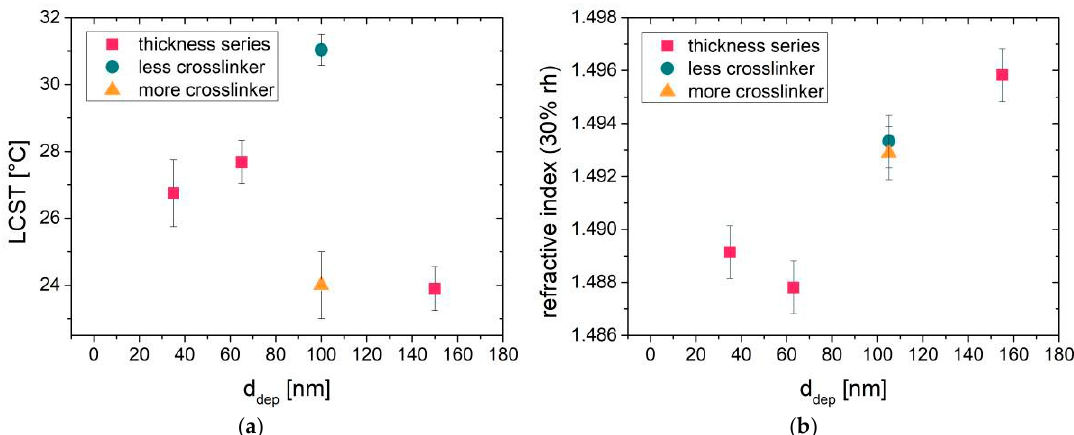
Figure 3. ( a ) Lower Critical Solution Temperature (LCST) evaluated from temperature dependent swelling experiments (see Figure 2) as a function of deposited film thickness (d dep ) as measured by spectroscopic ellipsometry in N 2 atmosphere; ( b ) Refractive index (at 633 nm) evaluated by spectroscopic ellipsometry measurements in a controlled relative humidity of 30% (at ~25 °C) as a function of the film thickness as measured by spectroscopic ellipsometry in N 2